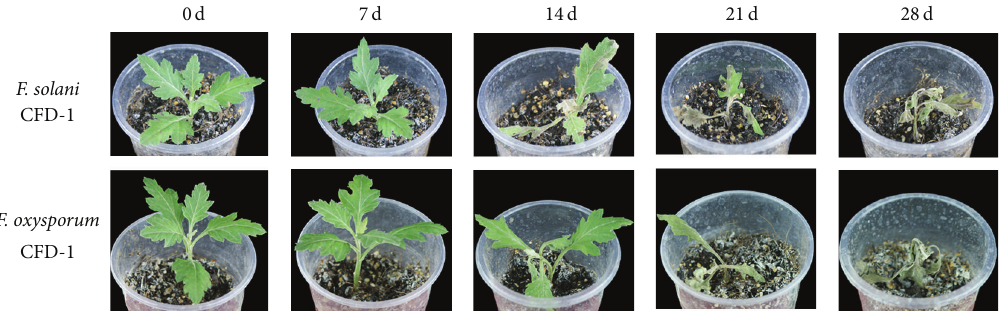
Figure 5: The temporal development of disease symptoms in chrysanthemum plants inoculated with either F. solani CFD-1 or F. oxysporum